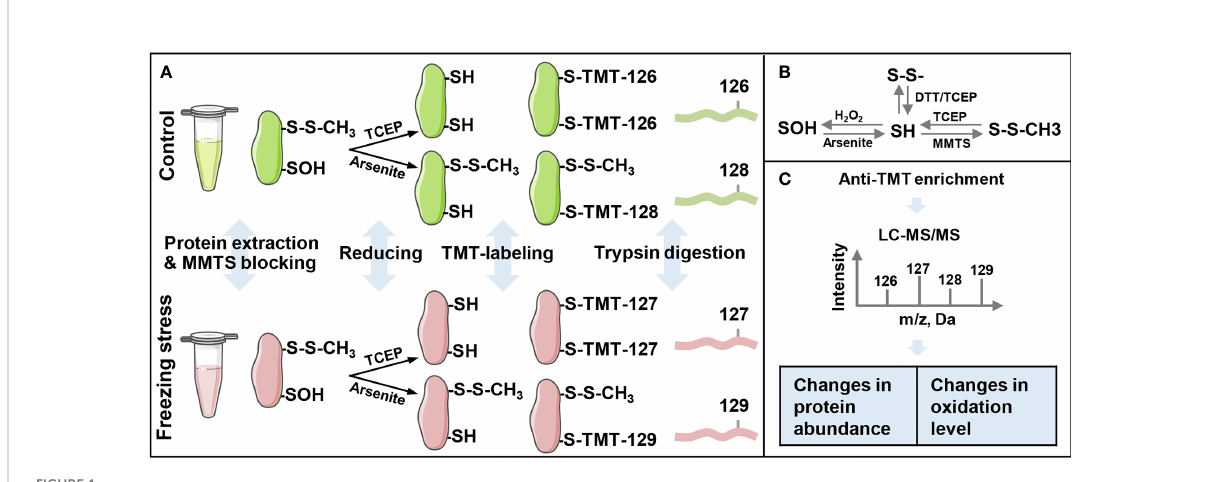
FIGURE 1 Work fl ow of the iodoacetyl tandem mass tags (iodoTMT)-based proteomic approach for the identi fi cation of sulfenylated cysteine sites. (A) The schematic of protein extraction, labeling and trypsin digestion processes. The iodo-TMT labels TMT-126 and TMT-127 were used to label free thiol (R-SH), and labels TMT-128 and TMT-129 were used to label sulfenylated thiol (R-SOH). (B) Thiol (SH) redox state change under different oxidants and reducing agents. SH, sulfhydryl group; S-S, disul fi de bond; SOH, sulfenylation group; MMTS, S-Methyl Methanethiosulfonate; TCEP, Tris (2-carboxyethyl) phosphine; DTT, dithiothreitol. (C) Anti-TMT ™ antibody-based enrichment and LC-MS/MS analysis of peptides ’ intensity. Changes in expression levels are calculated by the ratio of TMT-127 (freezing stress) to TMT-126 (control) and changes in sulfenylation levels are calculated by the ratio of %R-SOH (TMT-129/TMT-127) under freezing stress to %R-SOH (TMT-128/TMT-126) under control